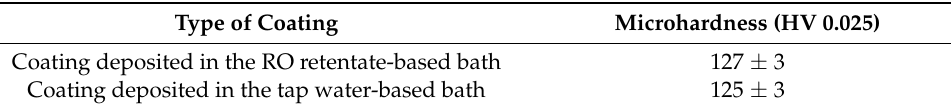
Table 7. Results of measurements of microhardness (HV 0.025) of zinc coatings obtained from two types of baths.